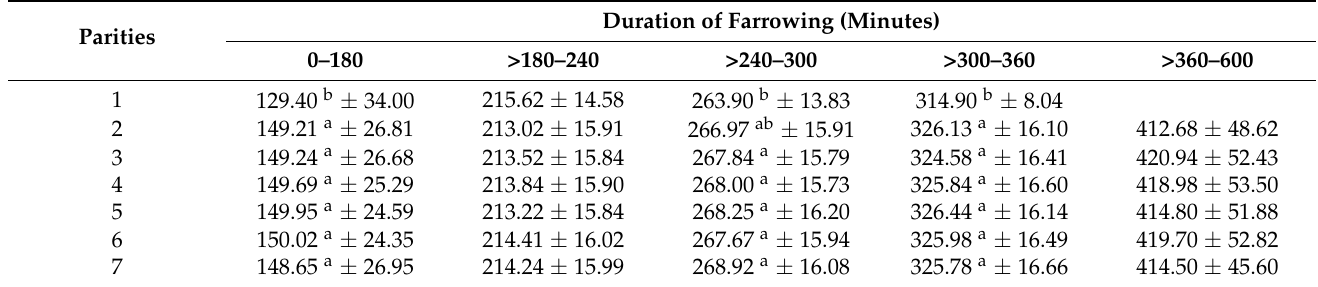
Table 6. Descriptive statistics of different groups of farrowing duration of different